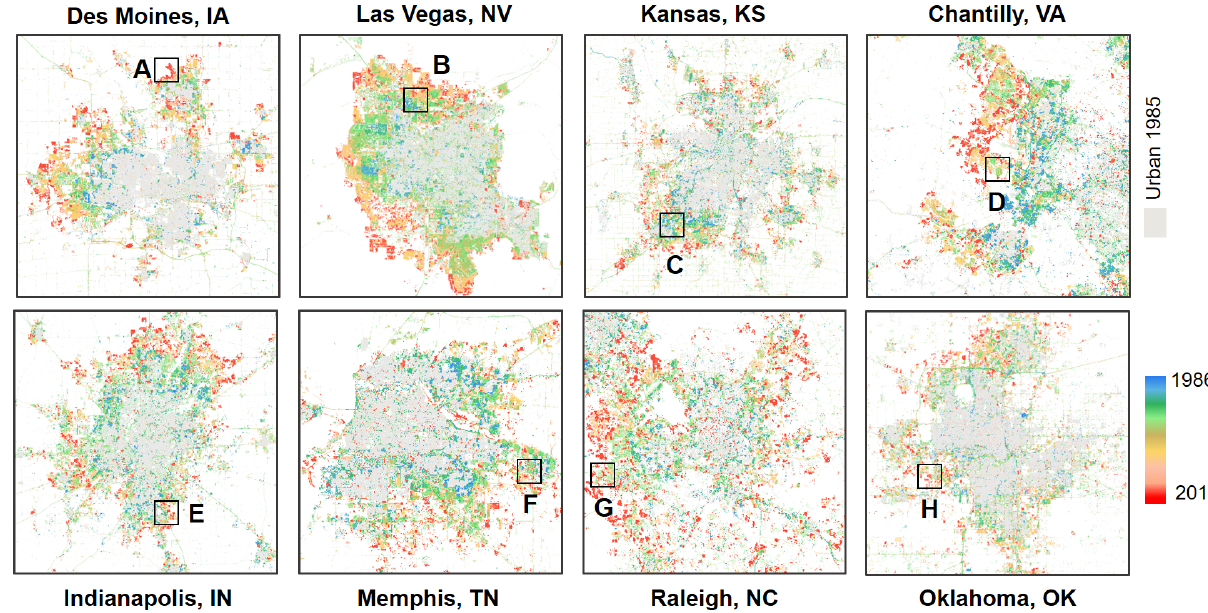
Figure 10. Annual dynamics of urban extent in eight selected US cities over the past three decades. The black frames are regions in Fig. 11 for further comparison with Landsat images. Table 1. Accuracy assessment of classified urbanized areas for periods B1 and